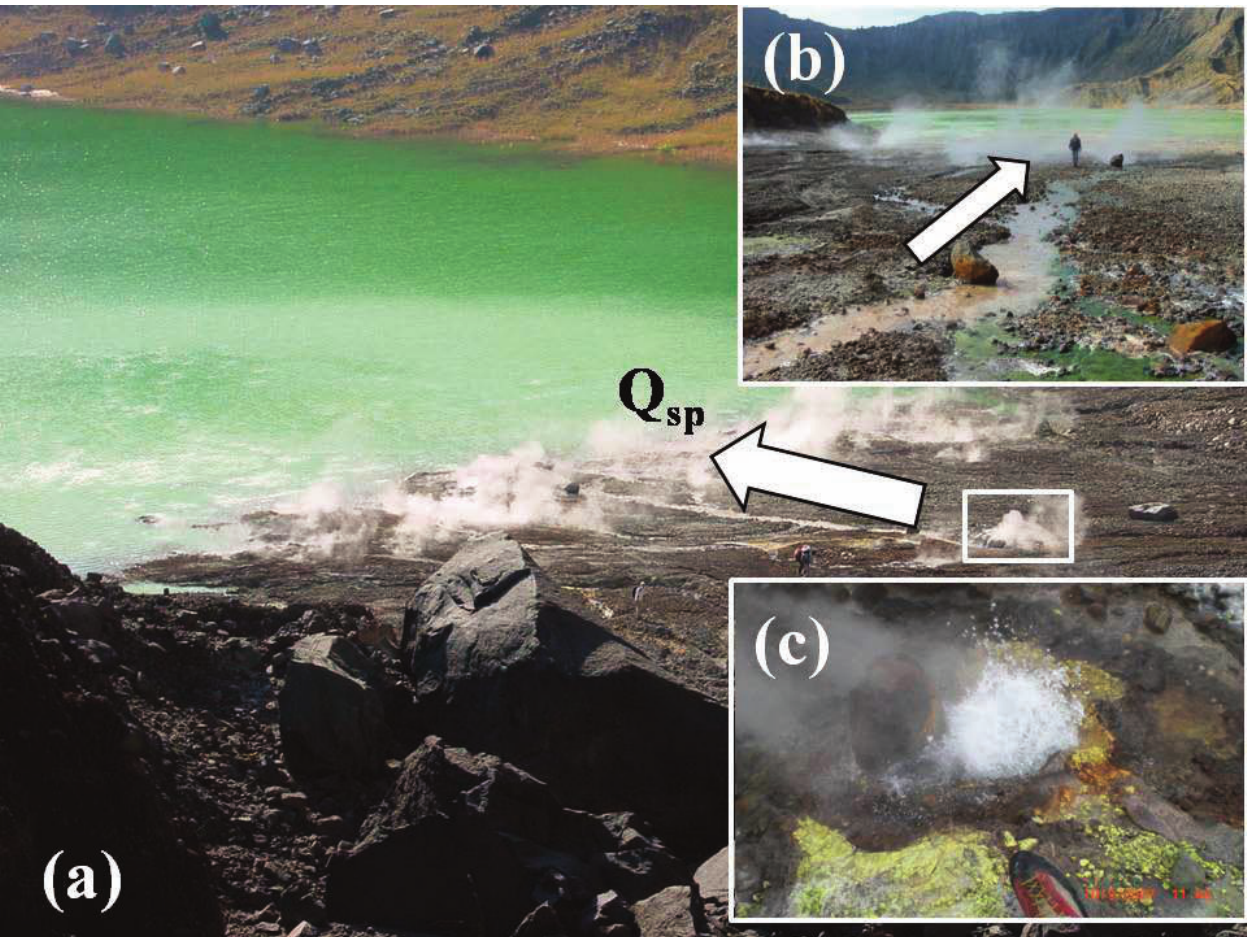
Figure 2. Discharge of a thermal spring (Qsp) towards an active crater lake (El Chichón, Chiapas, Mexico). (a) The white arrow indicates the discharge of thermal spring water towards the lake. The people indicate the scale (photograph: D. Rouwet). (b) A detail of the stream flow (photograph: Y. Taran), and (c) Geyser-like thermal spring, with a shoe to indicate scale (photograph: D. Rouwet). The white box indicates the location of the geyser-like thermal spring, enlarged in